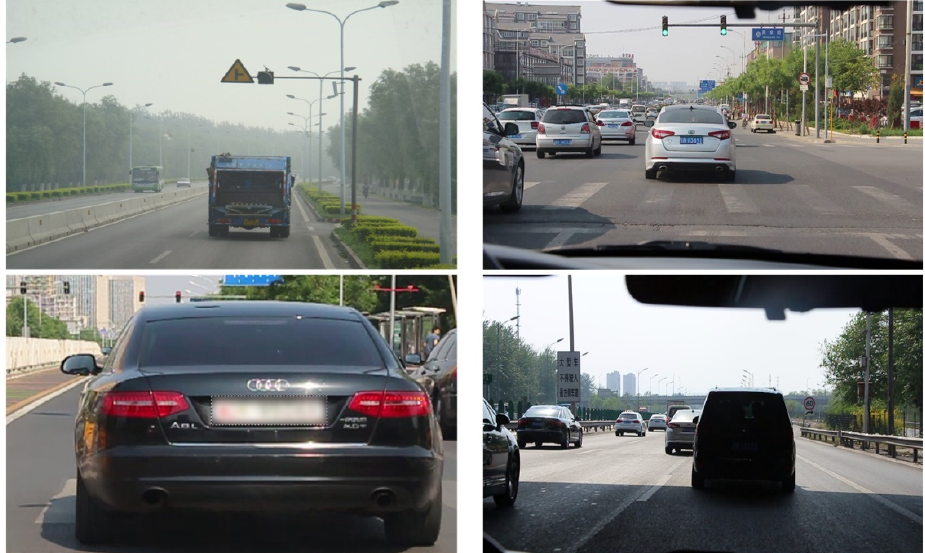
Figure 2. Example of CTSD data [38].